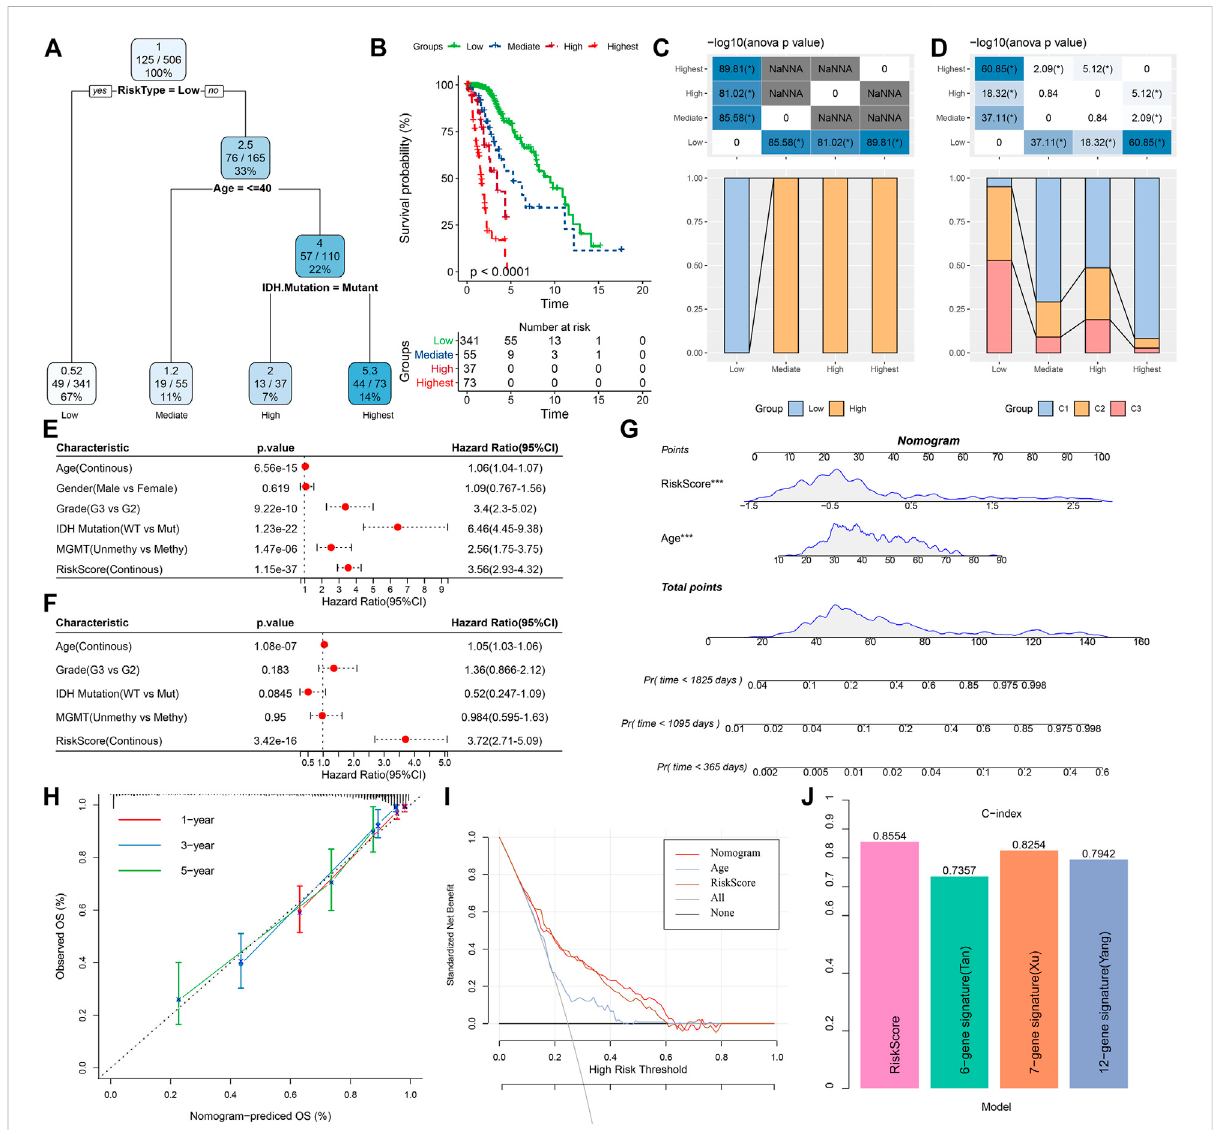
FIGURE 13 Determining optimal prognostic factors and determining their reliability by decision tree (A) Individuals with full-scale annotations including RiskScore, age, gender, and TNM stage were employed to develop a survival decision tree for optimizing risk strati fi cation. (B) Major variations of overall survival were observed among the four risk subgroups. (C,D) Comparative analysis among different subgroups. (E,F) Univariate and multivariate Cox analysis of RiskScore and clinicopathological properties. (G) Columnar line plot model. (H) Calibration curves for 1, 3, and 5 years for columnar line plots. (I) Decision curves for columnar line plots. (J) C-index of our risk model and other previously reported risk